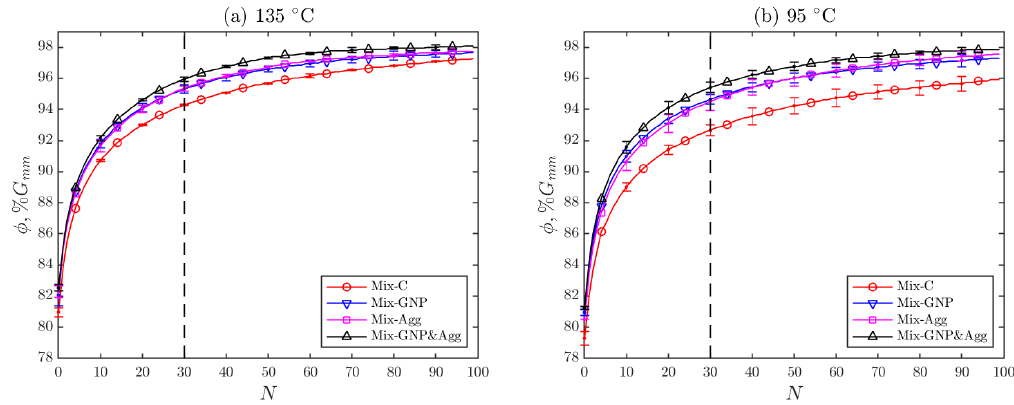
Figure 6. Gyratory compaction results at ( a ) 135 ◦ C and ( b ) 95 ◦